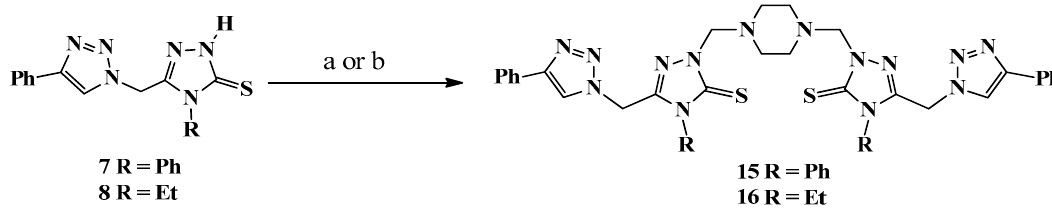
Table 1. Comparison between the conventional method (CM) and microwave irradiation (MW) in the synthesis of compounds 3 – 16 .